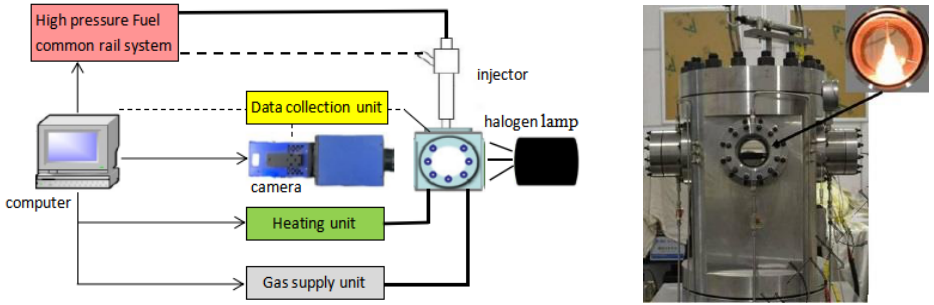
Figure 1. The visual test system of the constant volume combustion vessel.